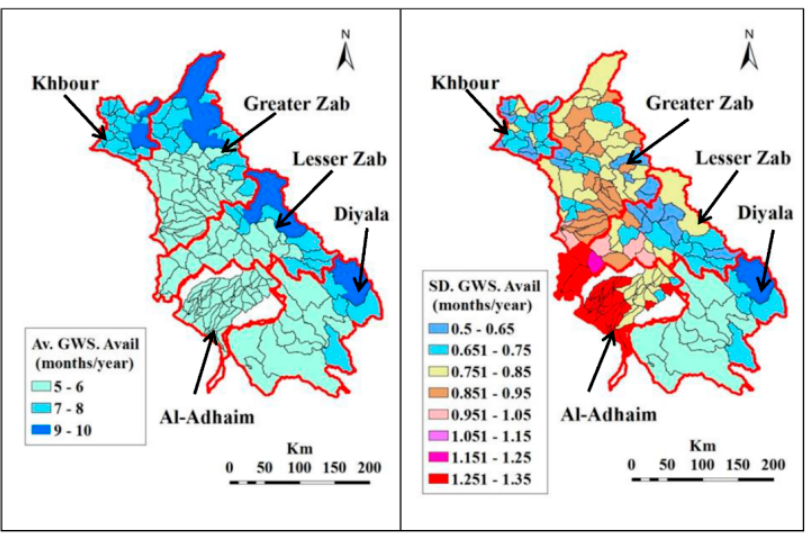
Figure 6. ( Left ) The 1980–2010 average green water storage (Av. GWS) and ( Right ) standard deviation calculated for the number of months per year where the green water storage is available (SD. GWS Avail).